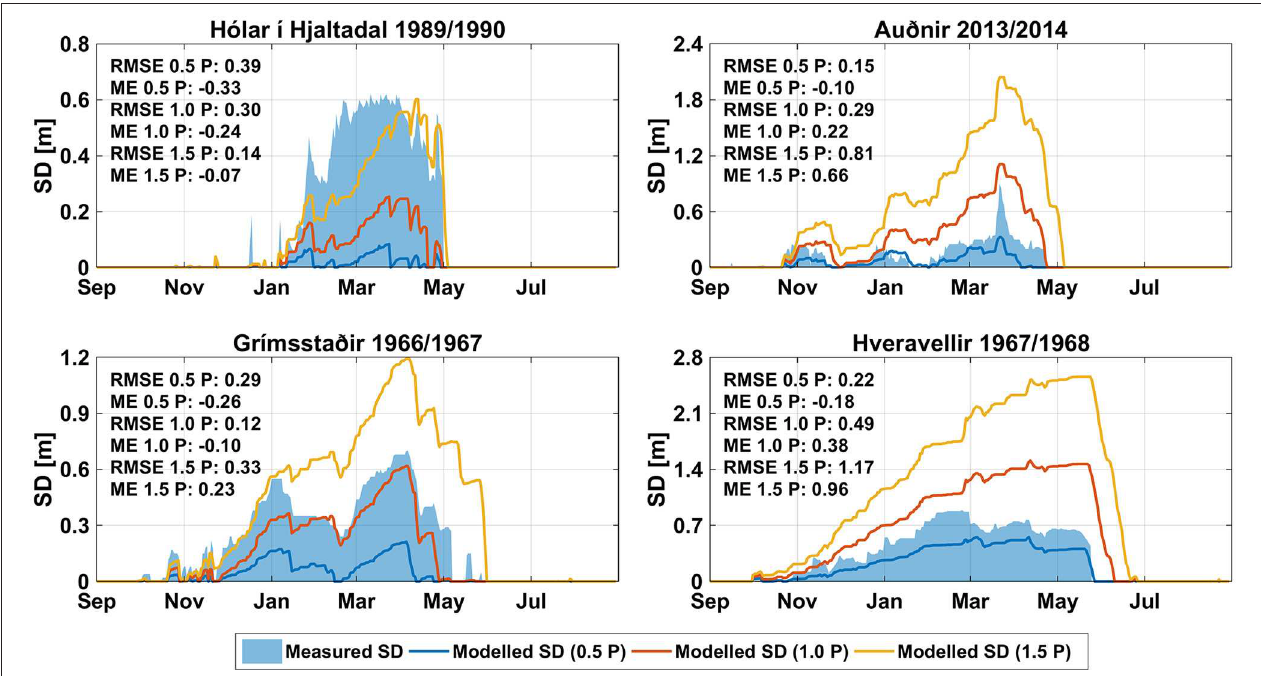
FIGURE 3 | Examples of measured and modelled daily SD (snow depth) for the three precipitation scenarios: 0.5P-50% precipitation, 1.0P-100% precipitation, 1.5P-150% precipitation. SD was obtained using the seNorge SWE sub-model (Saloranta, 2012) and snow density of 350kg m − 3 . RMSE-root mean square error, ME-mean